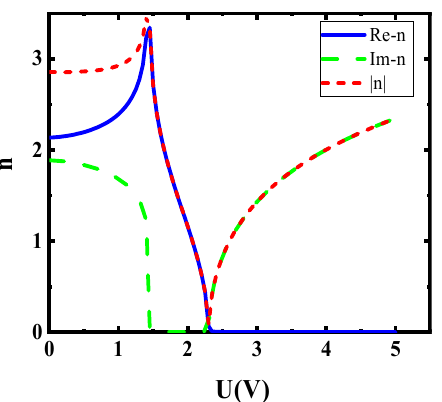
Figure 3. Dependence of graphene refractive index on the external voltage in 1550 nm incident wavelength.